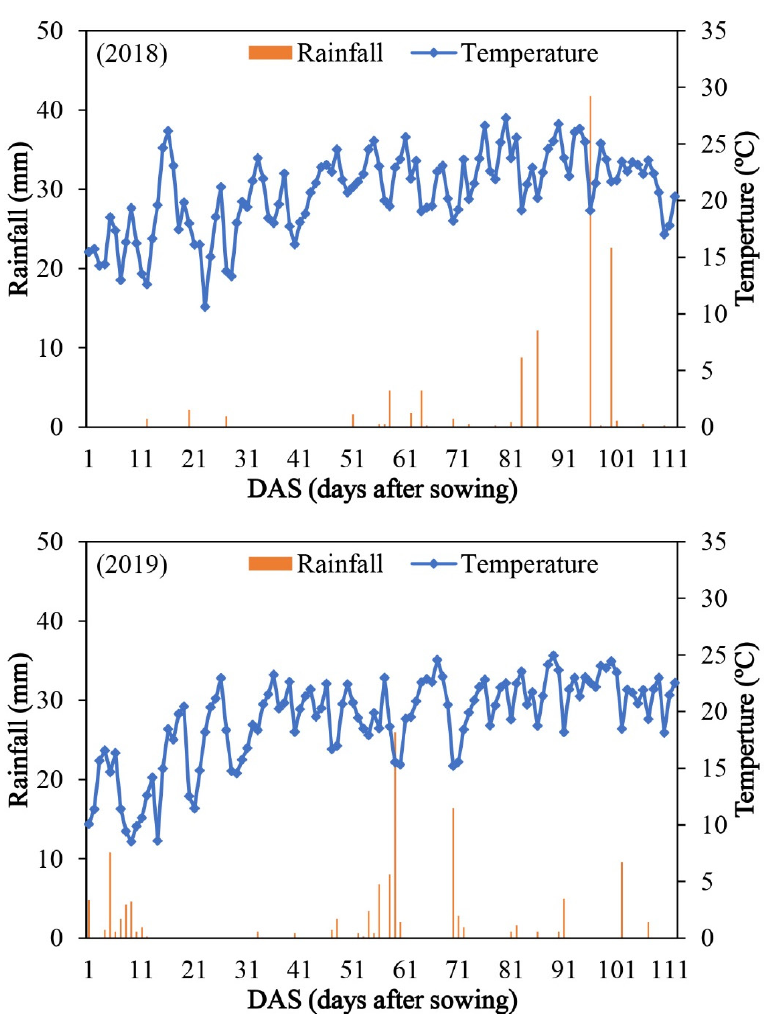
Figure 2. Rainfall and mean air temperature at 2.0 m height during the quinoa growing seasons in 2018 and 2019 at Wuwei, Gansu Province, China.